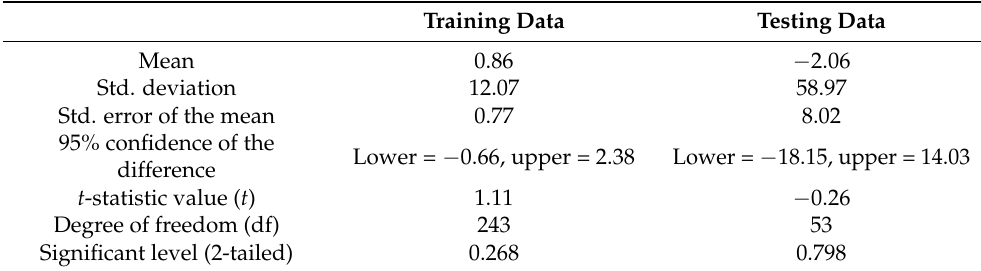
Table 2. Comparing actual values from the training and test data sets of the proposed model to those expected values in a paired sample t